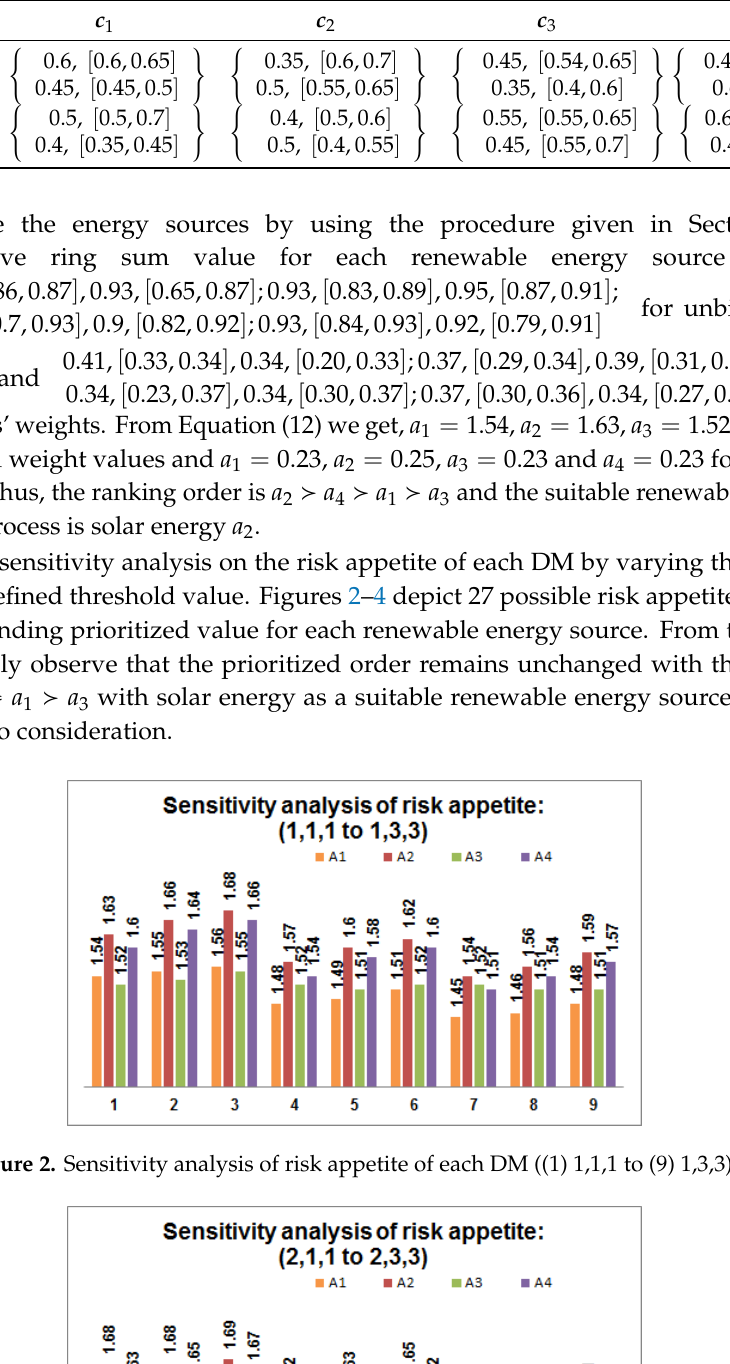
Figure 4. Sensitivity analysis of risk appetite of each DM ((19) 3,1,1 to (27) 3,3,3). Step 6: End. 5. Comparative Analysis of Proposed Decision Framework This section put forwards a comparative study of the proposed aggregation operator with other operators in the IVPHFS context. In order to maintain the homogeneity of the comparison process, we analyse the proposed method with aggregation operators from References [18] and [19] which uses IVPHFEs as preference information.